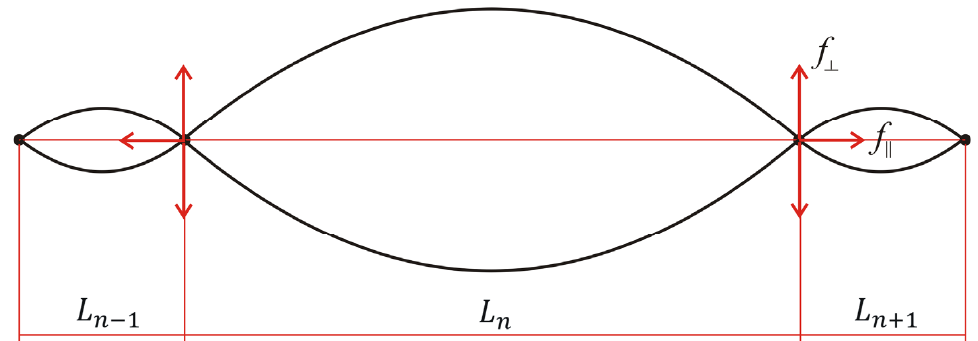
Figure 5. Scheme representing the forces acting on pinning points from segments of an oscillating dislocation [38].